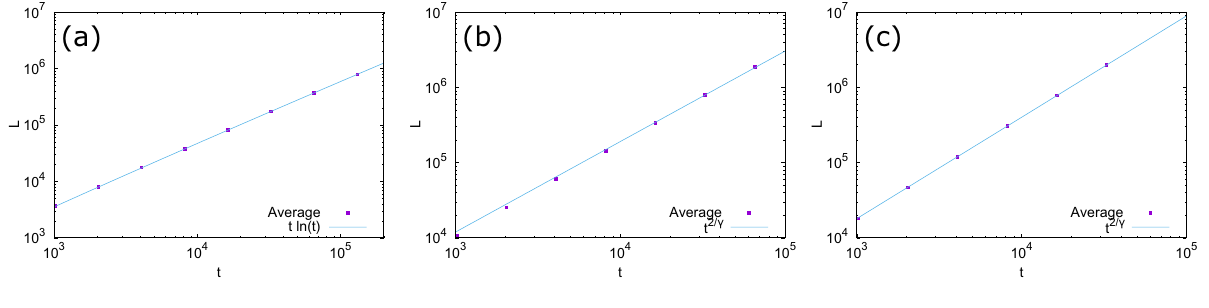
3 √ 2 . Solid lines are the best fitting of 1 , ( b ) δ δ 2 , and ( c ) = (cid:31) = =